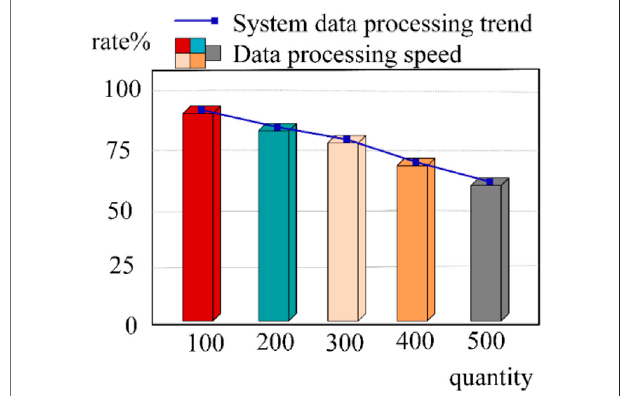
FIGURE 5 | Data processing ef fi ciency diagram of optimized discrete dynamic